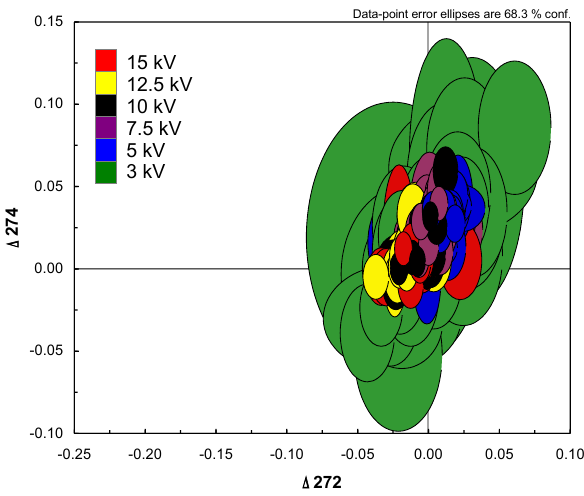
Figure 5. (cid:49) 272 vs. (cid:49) 274 plots for zircon analyses at 3–15kV pri- mary energies. Repeated analyses in the same sputter crater are lighter colours. Colour coding by impact energy is the same as for previous figures. Add 680V for impact